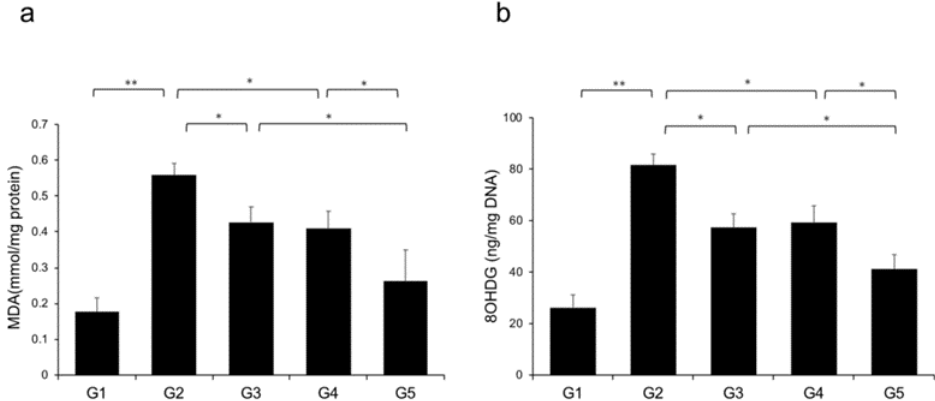
Figure 9. Effects of canagliflozin (CA) and teneligliptin (TE) on hepatic reactive oxygen species (ROS) production; ( A ) malondialdehyde ( B ) 8-hydroxy-2'-deoxyguanosine. G1, Group 1 (choline- sufficient, L-amino acid-defined diet); G2, Group 2 (choline-deficient, L-amino acid-defined diet (CDAA)); G3, Group 3 (CDAA+canagliflozin (CA)); G4, Group 4 (CDAA+ teneligliptin (TE)); G5, Group 5 (CDAA+CA+TE); Values represent mean ± SD ( n = 10). * p < 0.05, ** p < 0.01.